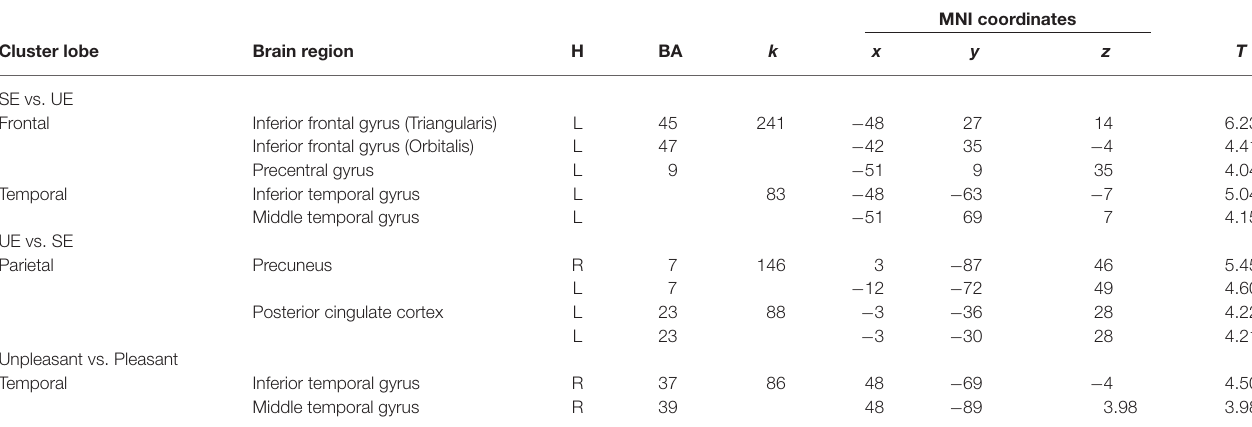
TABLE 1 | Summary of the regions significantly activated based on the random-effect group analysis for the main effect of encoding performance and pleasantness